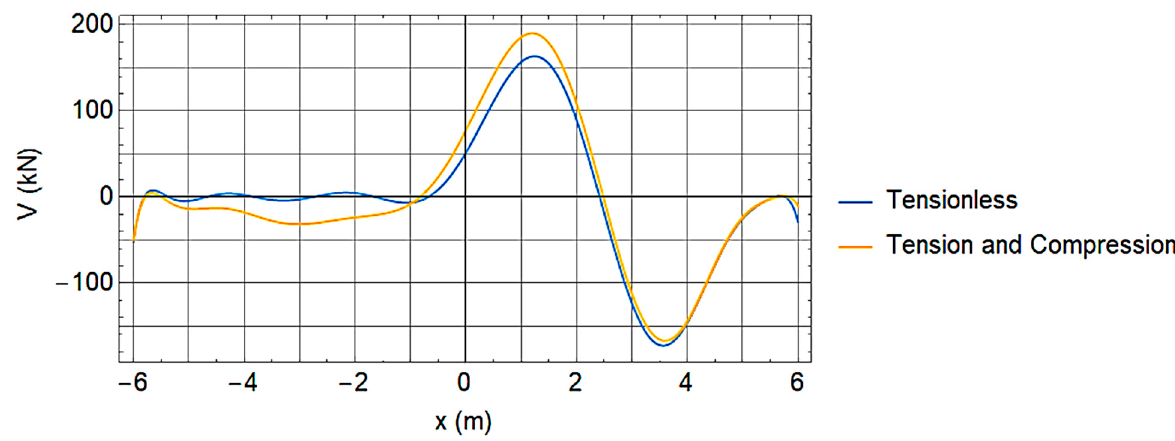
Figure 12. The shear force diagram for the asymmetric case (X = L/5 )